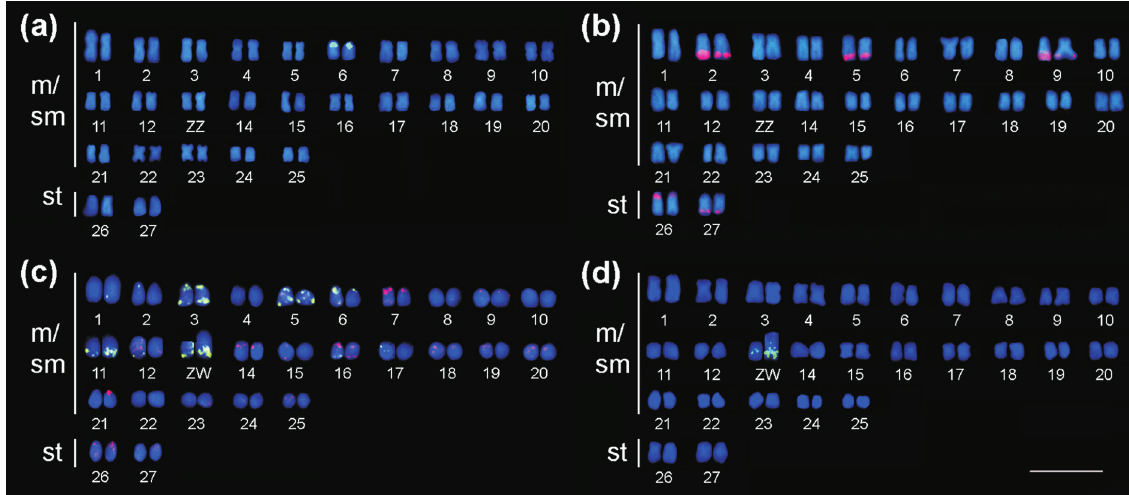
Figure 3 - Karyotypes of the Apareiodon sp. submitted to probing for in situ localization: in (a) 5S rDNA (green); (b) 18S rDNA (red); (c) p Ph 2004 (green) and (GATA)n (red) and; (d) W Ap probe (green). Bar = 10 (cid:2) m.